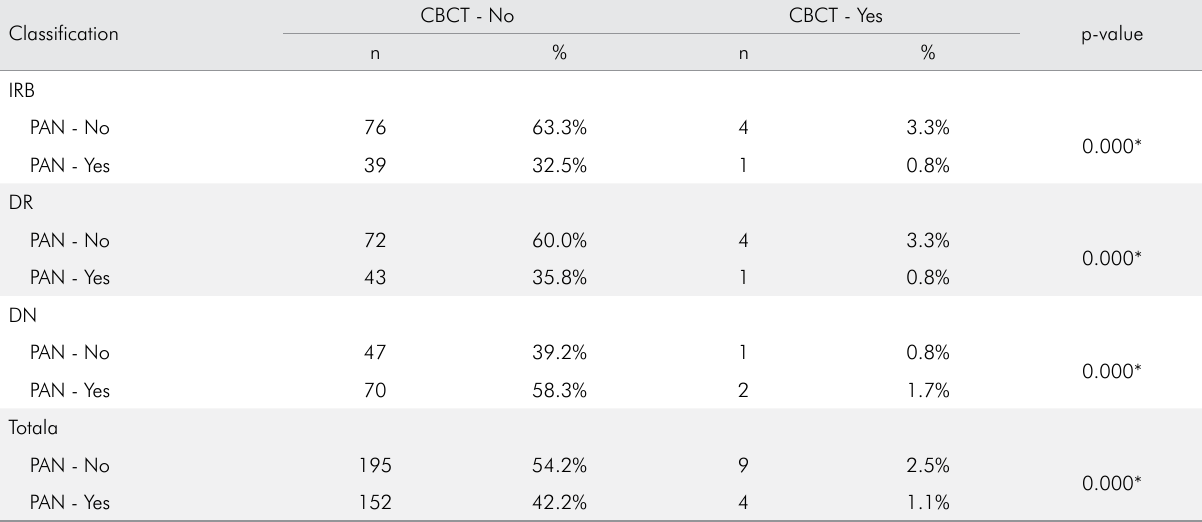
Table 6. Answers to the question “Would you request an additional imaging exam?” before (PAN) and after CBCT.